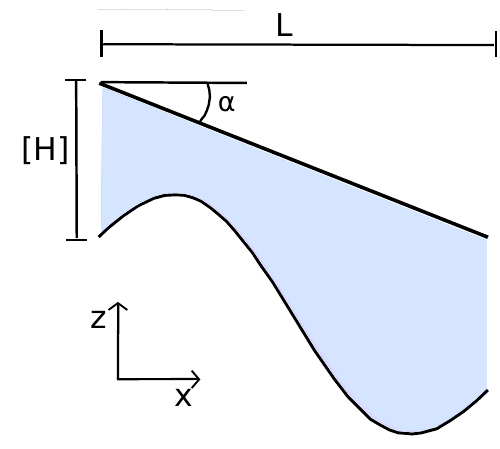
Fig. 1. Model set-up showing the basal topography and the ice sur- face. The ice flows down-slope in the positive x -direction.